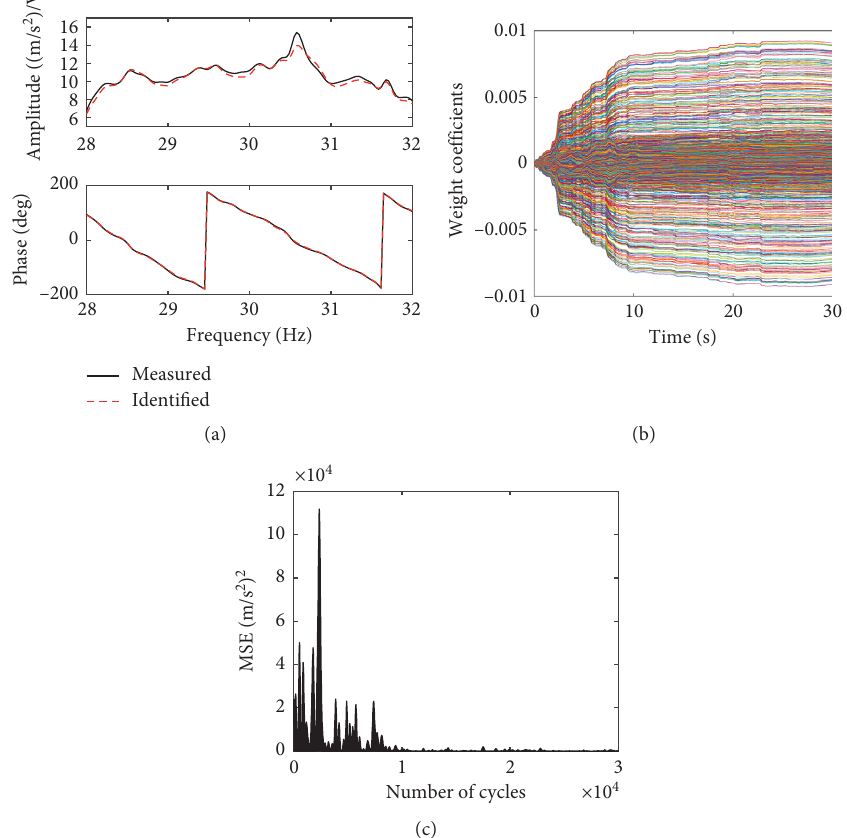
Figure 6: Offline identification results of control channel: (a) comparison of frequency response functions; (b) adaptive filter weight coefficient iteration curves; (c) MSE of the identification model.